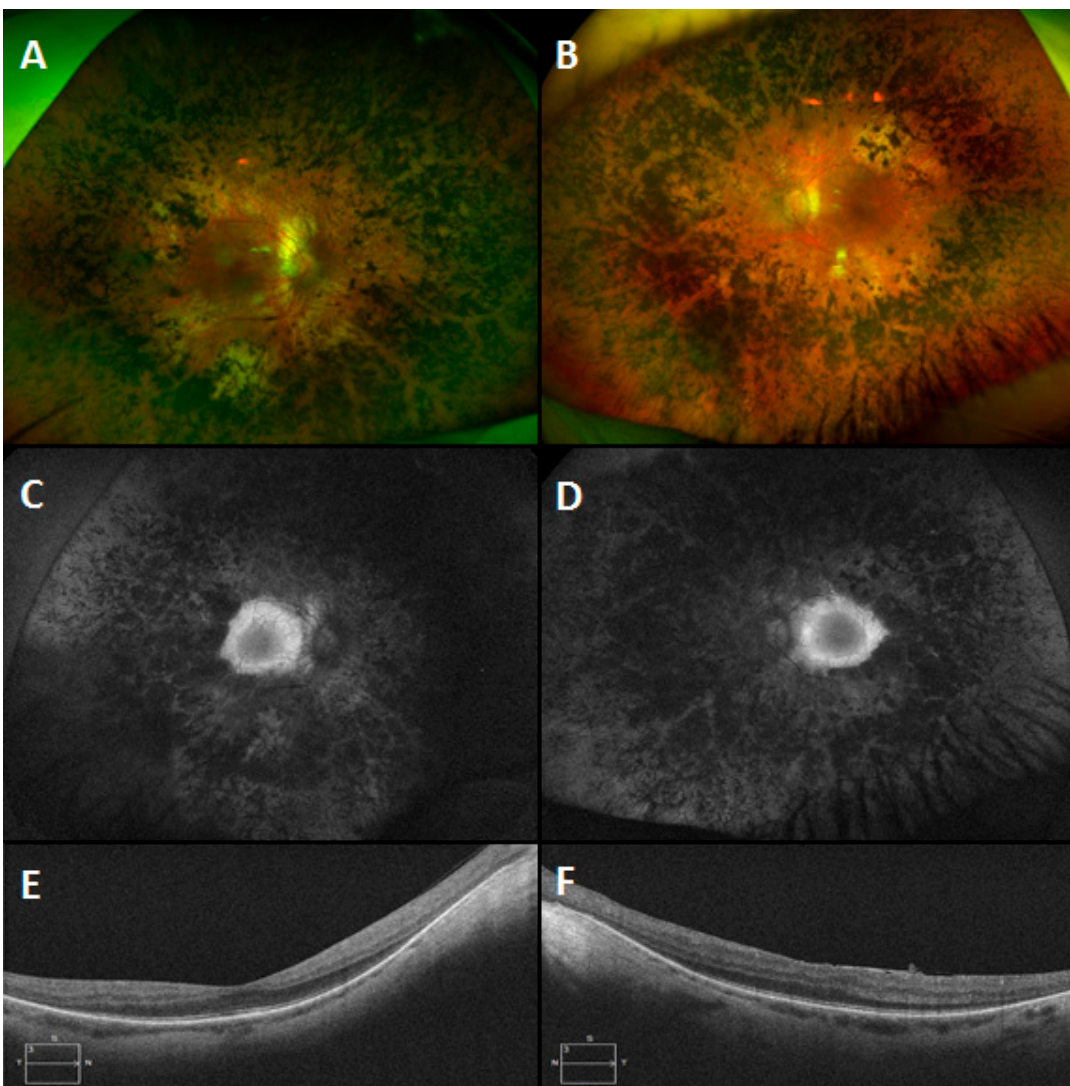
Figure 7. Montage of clinical images from an Usher syndromepatient with a large homozygous deletion in USH1C . Colour images of the right ( A ) and left ( B ) eyes of a 44 year old male patient with Usher syndrome type 1 which show symmetrical circumferential mid ‐ peripheral bone spicule pigmentation and RPE atrophy with relative preservation of the maculae. The corresponding autofluorescence images of the right ( C ) and left ( D ) eyes demonstrate peripheral hypoautofluorescence and preserved macular autofluorescence. Note the symmetrical hyperautofluorescent rings, which correspond to the extent of the preserved macular photoreceptors on the Optical Coherence Tomography (OCT) scans ( E : right eye and F : left eye).